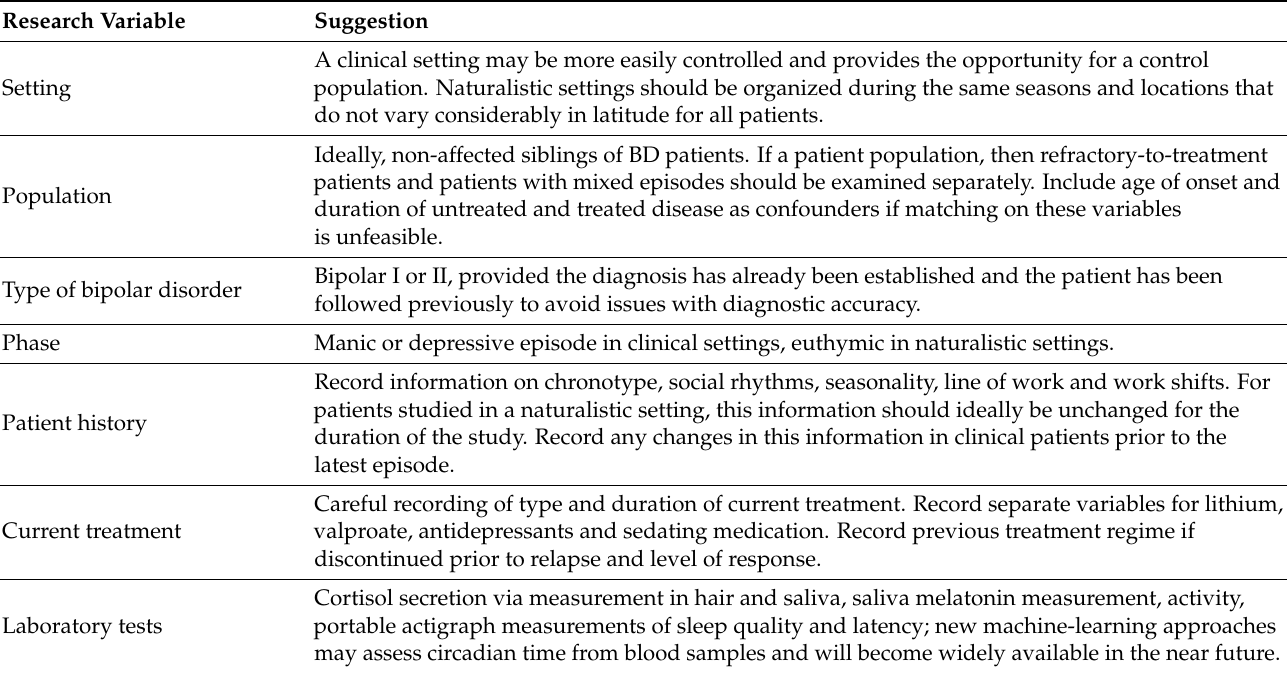
Table 2. Suggestions for future research by research